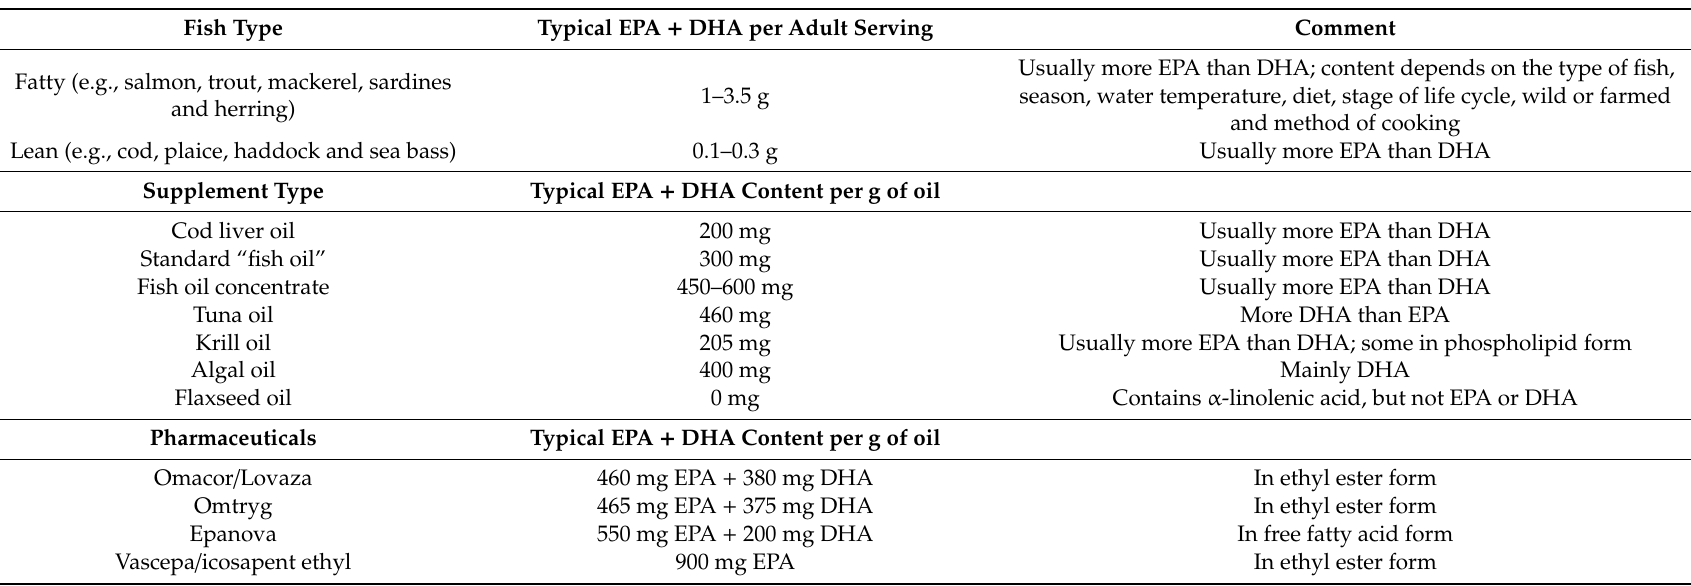
Table 1. Content of EPA and DHA in fatty fish, lean fish, supplements and